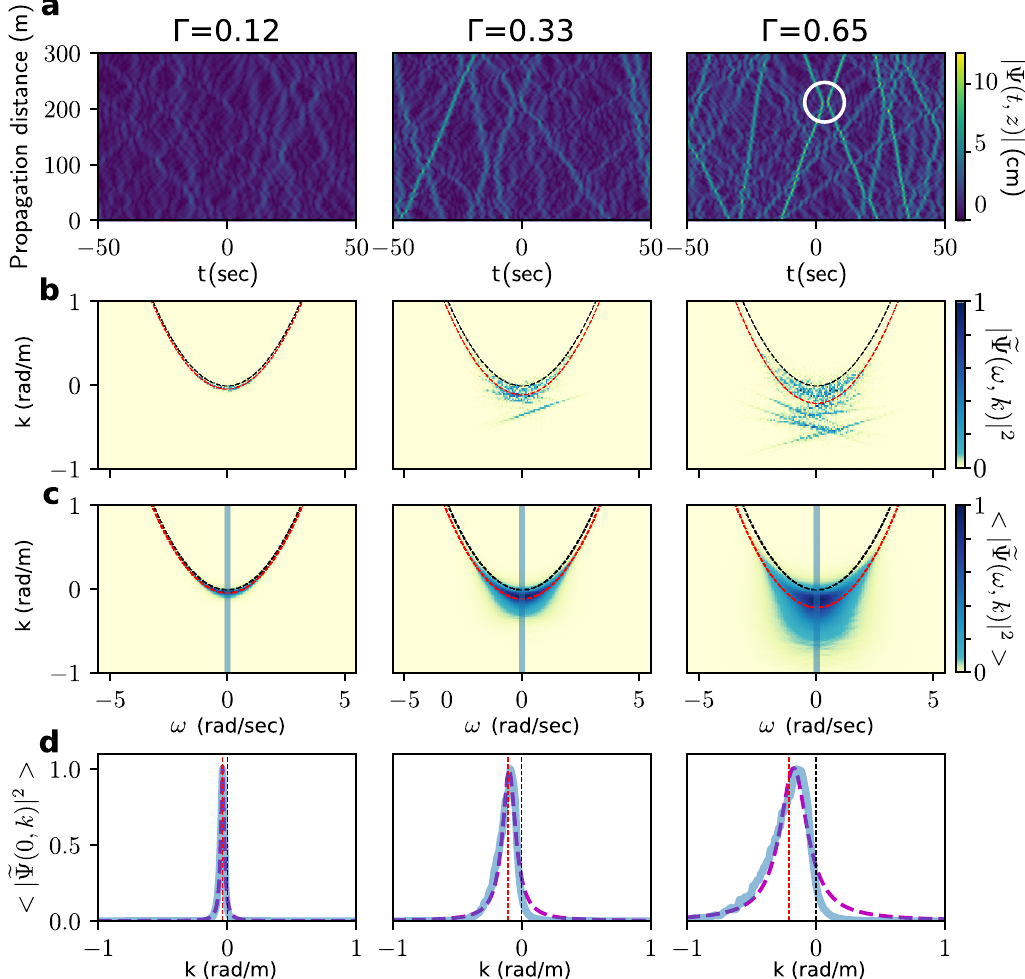
Figure 1. Numerical simulations of the 1-D NLS equation. Three columns correspond to three different values of Ŵ 0.12, 0.33, and 0.65, respectively. The central frequency of the carrier wave and the initial width of the 1.15 Hz and (cid:31) f 0.2 Hz. (a) Spatiotemporal diagram for the complex envelope wave spectrum are set to f 0 = = 2 normalized to the maximum. ψ( t , z ) ψ(ω , k ) amplitude . (b) Corresponding nonlinear dispersion relation | | | | (c) Nonlinear dispersion relation averaged over 1000 realizations and normalized to the maximum. Propagation (cid:31) 0 (along the blue line distance is 500 m. (d) Cross-section of the averaged nonlinear dispersion relation at ω = in c ). Dashed purple line shows a Lorentzian fit. In (b–d) , vertical black and red dashed lines represent the linear dispersion k (ω) and its nonlinear correction of Eq. (5)